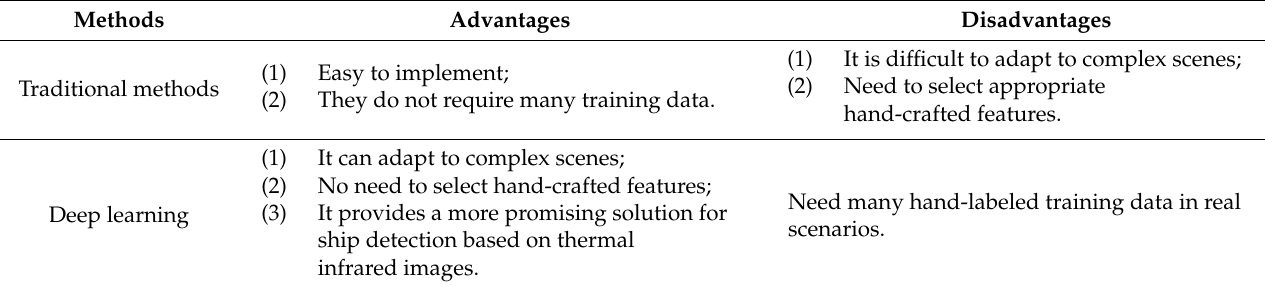
Table 8. Advantages and disadvantages of traditional methods and deep learning methods in ship detection. Methods Advantages Disadvantages Traditional methods